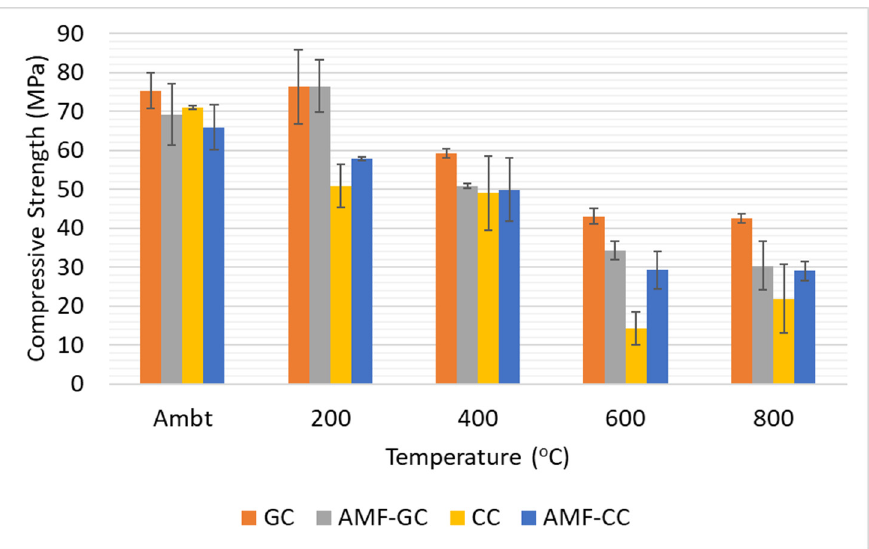
Figure 5. Compressive strength of unreinforced and AMF reinforced cement and geopolymer composites.